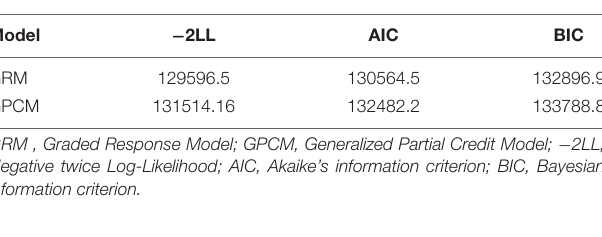
TABLE 3 | Test-fit results for two polytomous-scored IRT models.